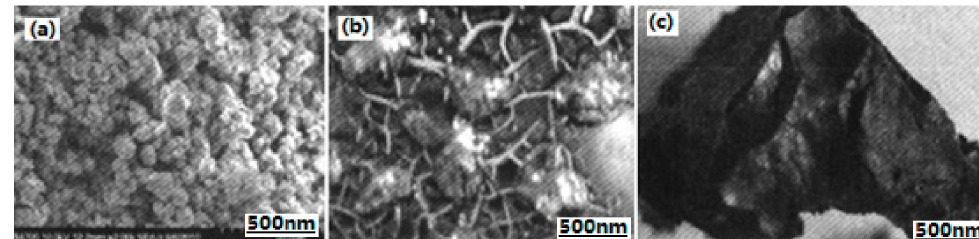
Figure 16. SEM photos of di ff erent particles. ( a ) Nano-sized Al / RDX / AP / SiO 2 composite; ( b ) gel complex by vacuum freeze drying; and ( c ) gel complex by supercritical drying. Reproduced from [55], with permission from Nanjing University of Science and Technology,